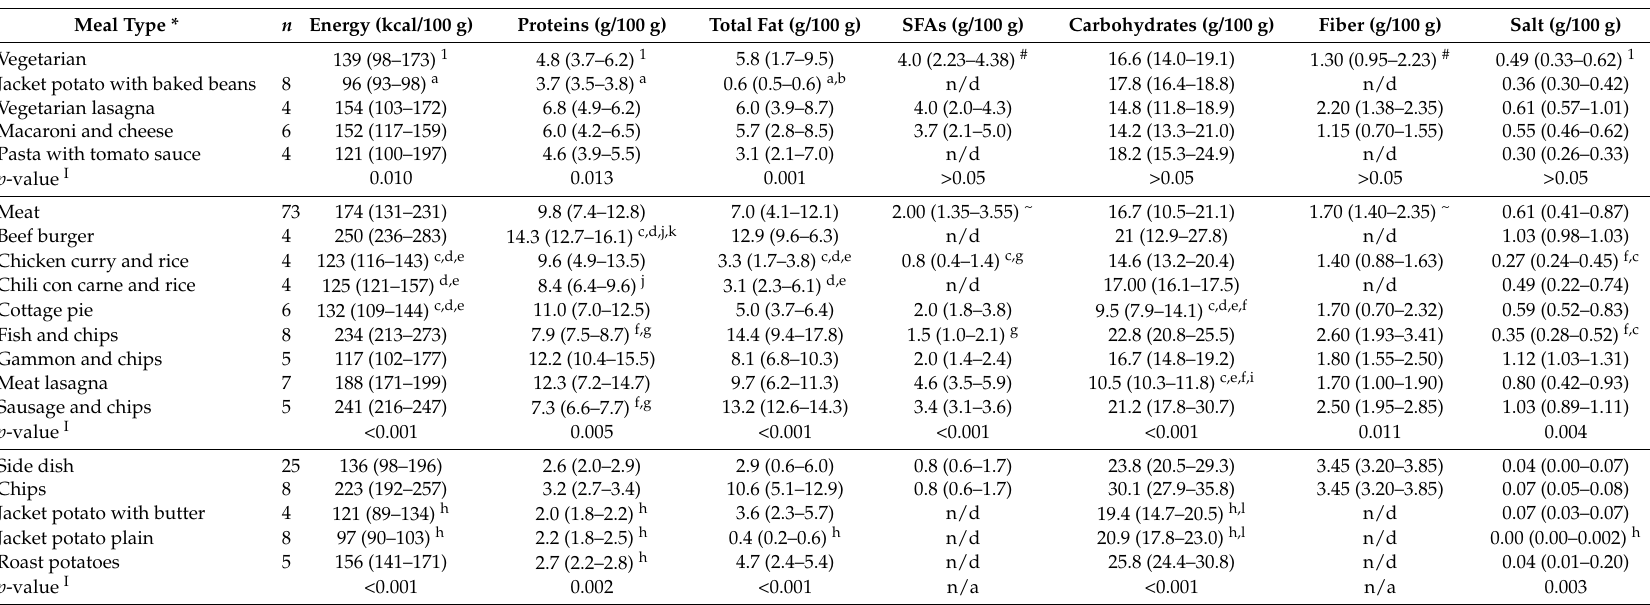
Table 1. Nutritional composition of meals served in hospital staff canteens per 100